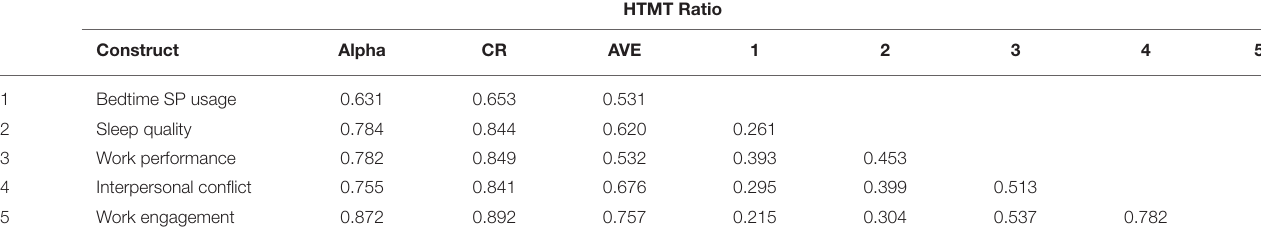
TABLE 3 | Construct reliability and validity.